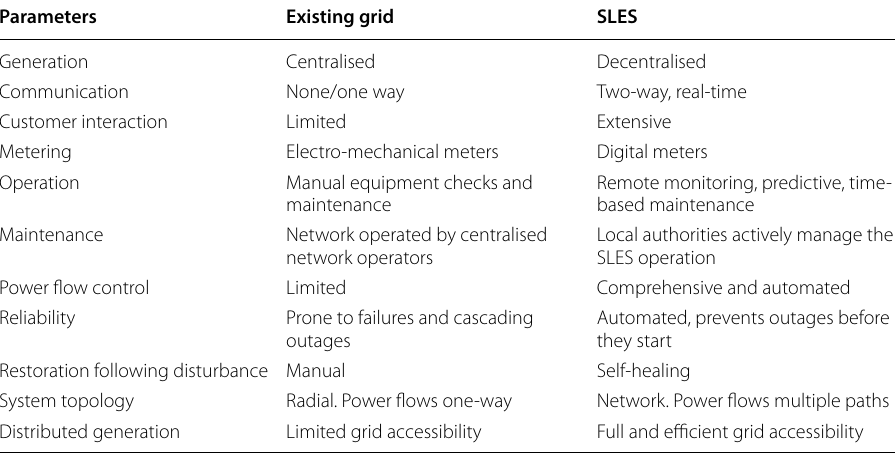
Table 1 Comparison between traditional grid and SLES (Ford et al. 2021; Alotaibi et al.